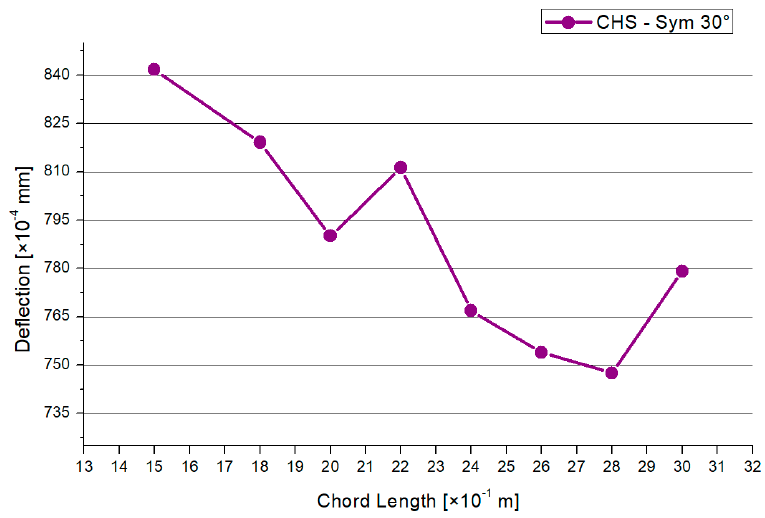
Figure 9. Results—Maximum Deflection.